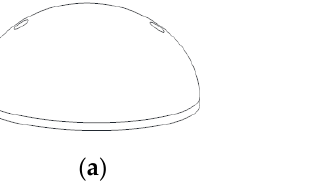
Figure 29. Liquid film thickness clouds for an ultra-large ellipsoidal recovery hood. It can be seen from Figure 30 that, as the spraying time increases, the film is relatively homogeneous away from the current spraying sector, probably due to the second type of small splash angle paint mist driven by the air diffusion along the outer hull plate to both sides of the spraying sector, and then the blowing effect, making the deposited film more homogeneous away from the current spraying sector. Figure 30. Relation between inhale pressure and the air velocity.